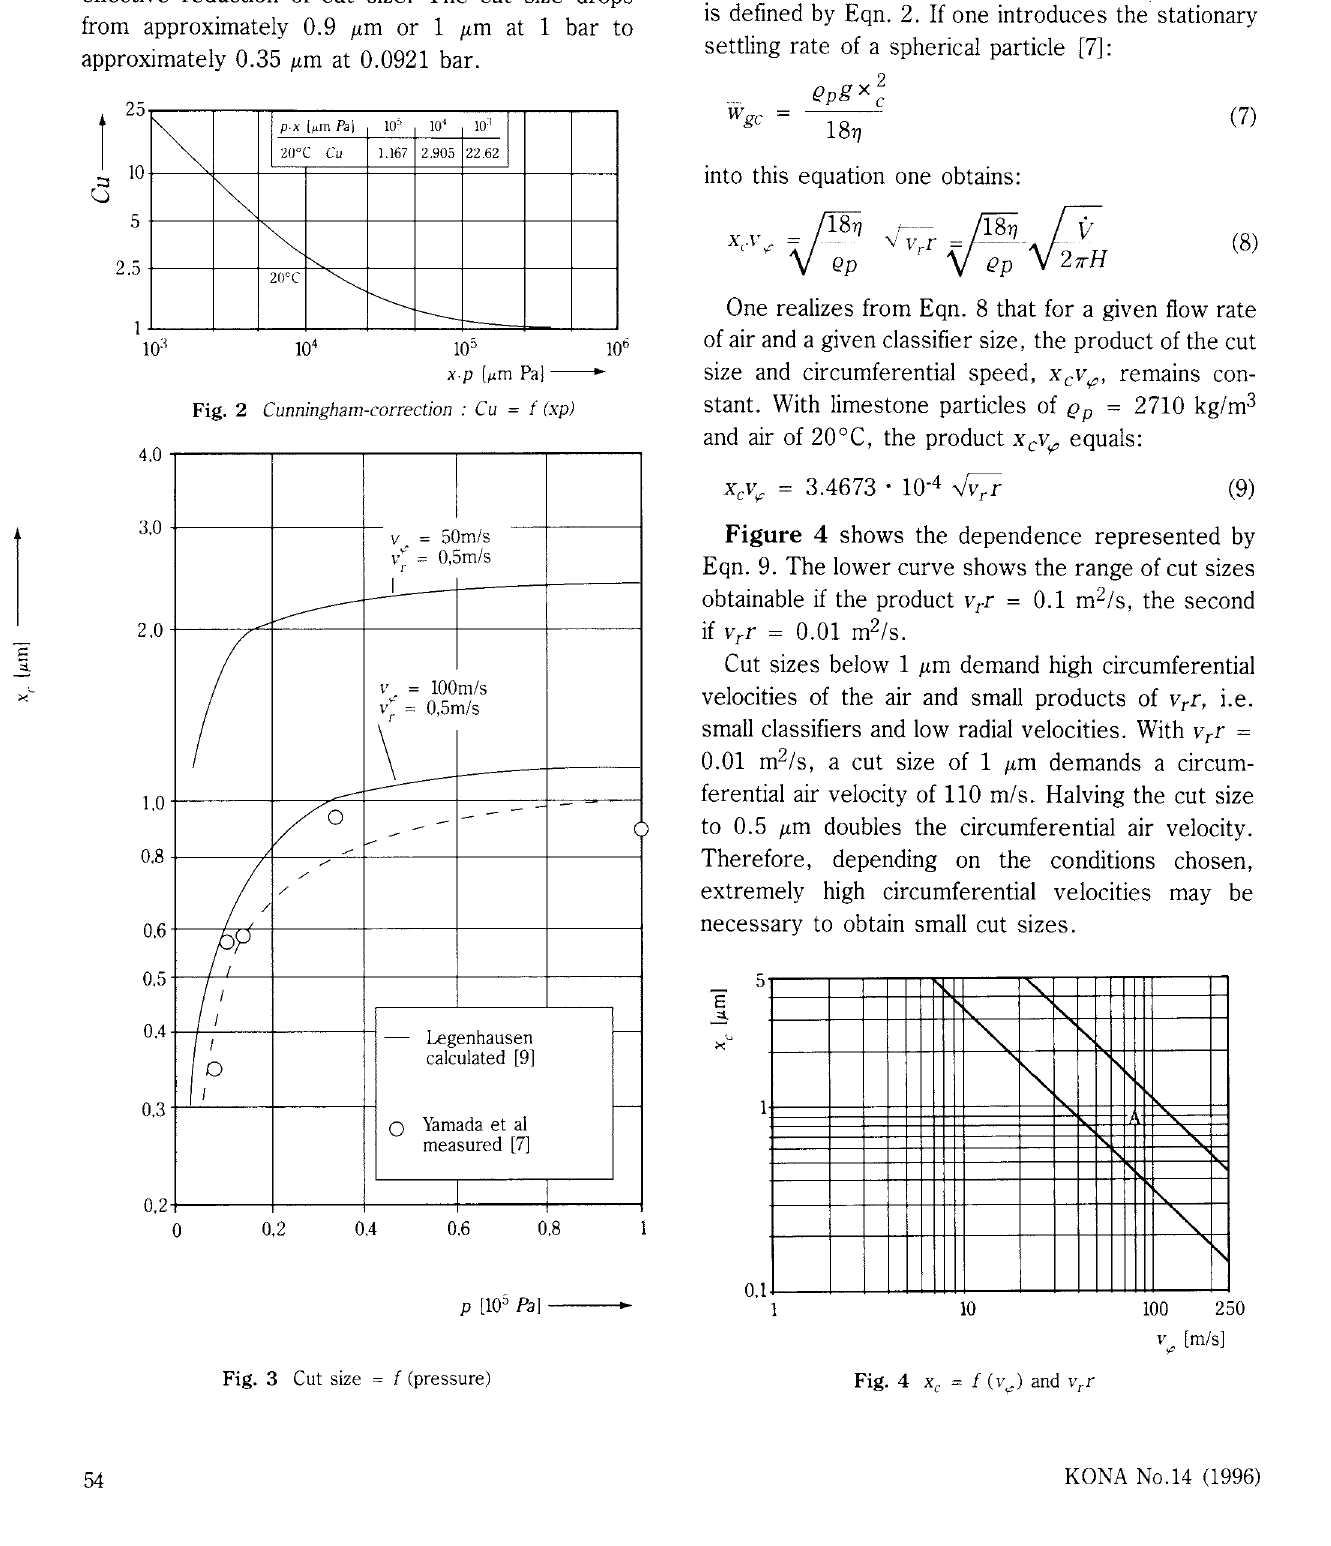
Fig. 3 Cut size = f